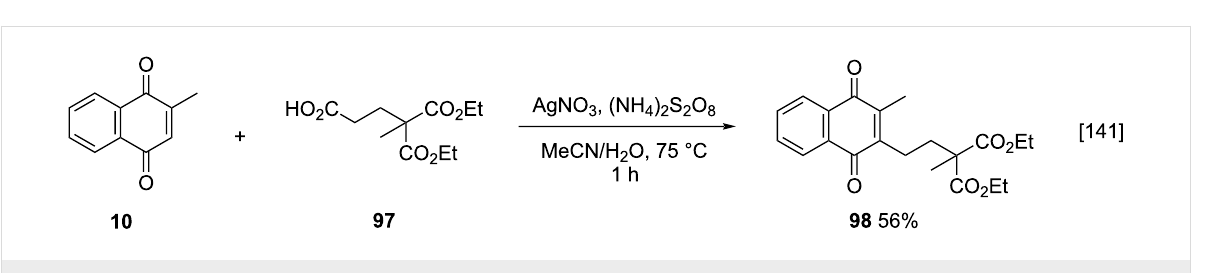
Scheme 33: Menadione alkylation by complex carboxylic